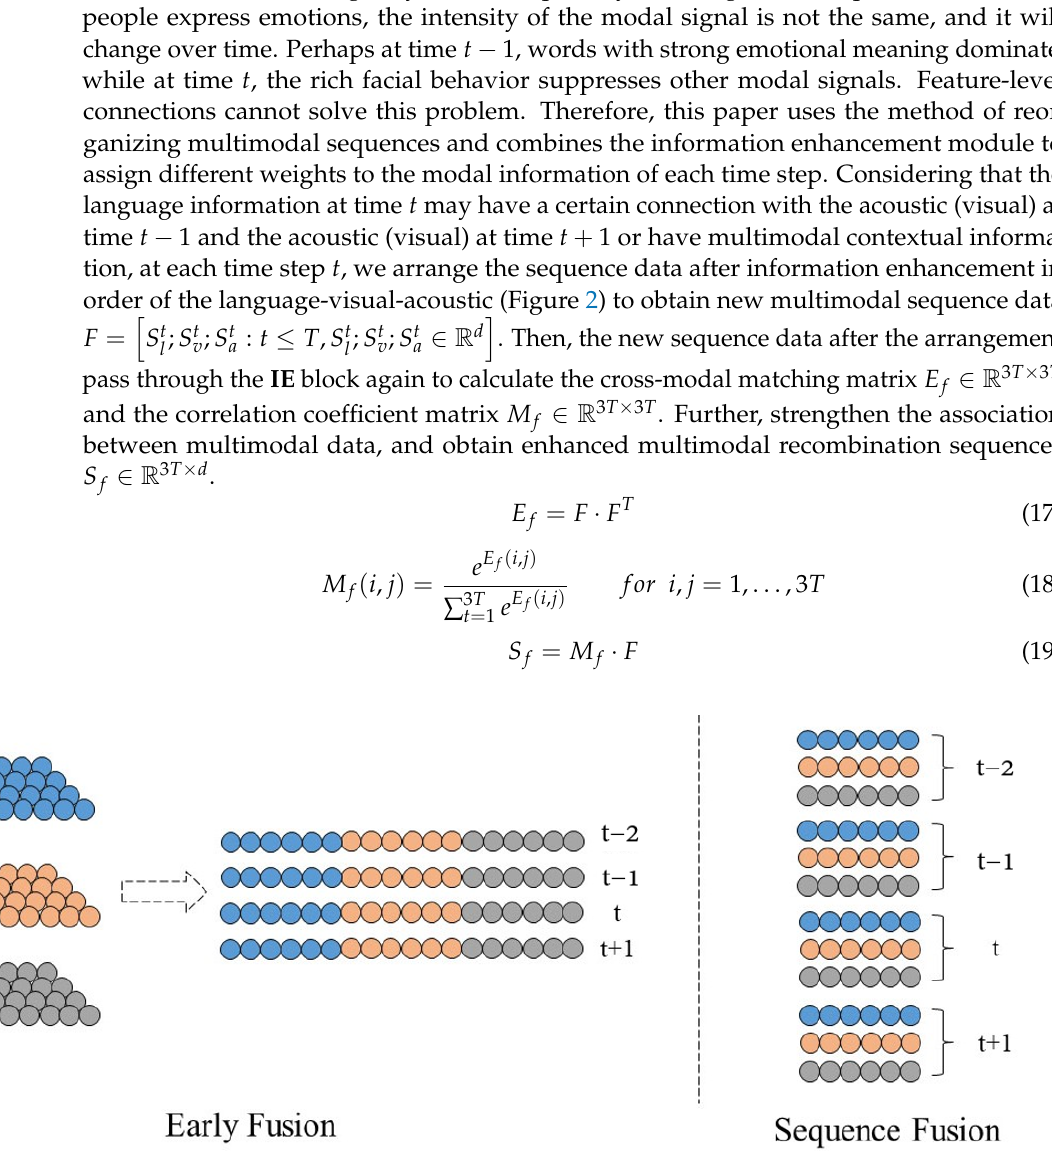
Figure 2. The left picture shows the traditional feature cascading method, and the right picture shows the new multimodal time series